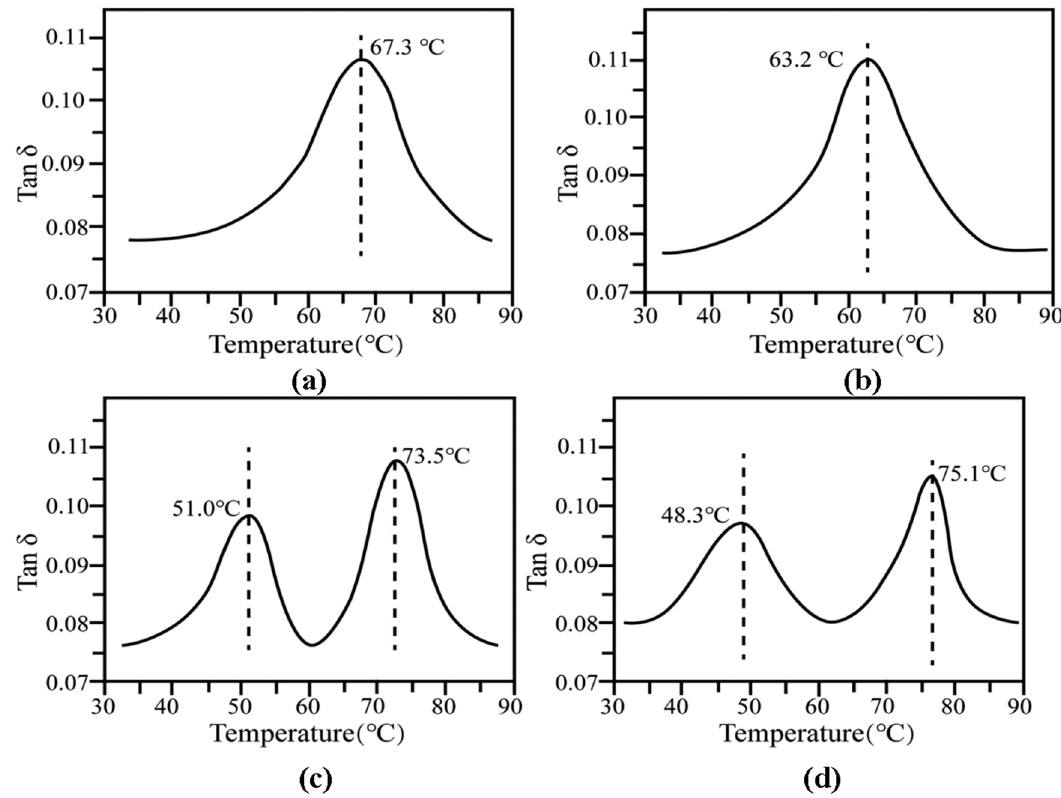
Figure 6: Glass transition temperature ( T g ) of bio - based PA56/PET blends measured using DMA method: ( a ) 10% PA56, ( b ) 20% PA56, ( c ) 30% PA56, and ( d ) 40%